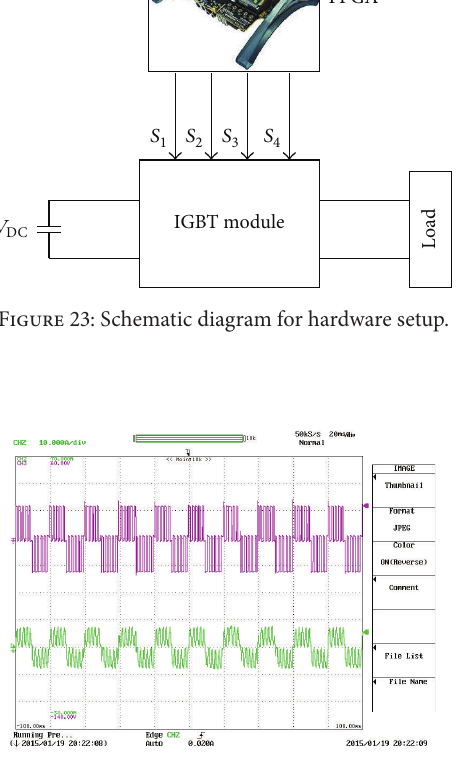
Figure 24: Load voltage and load current through RL load.